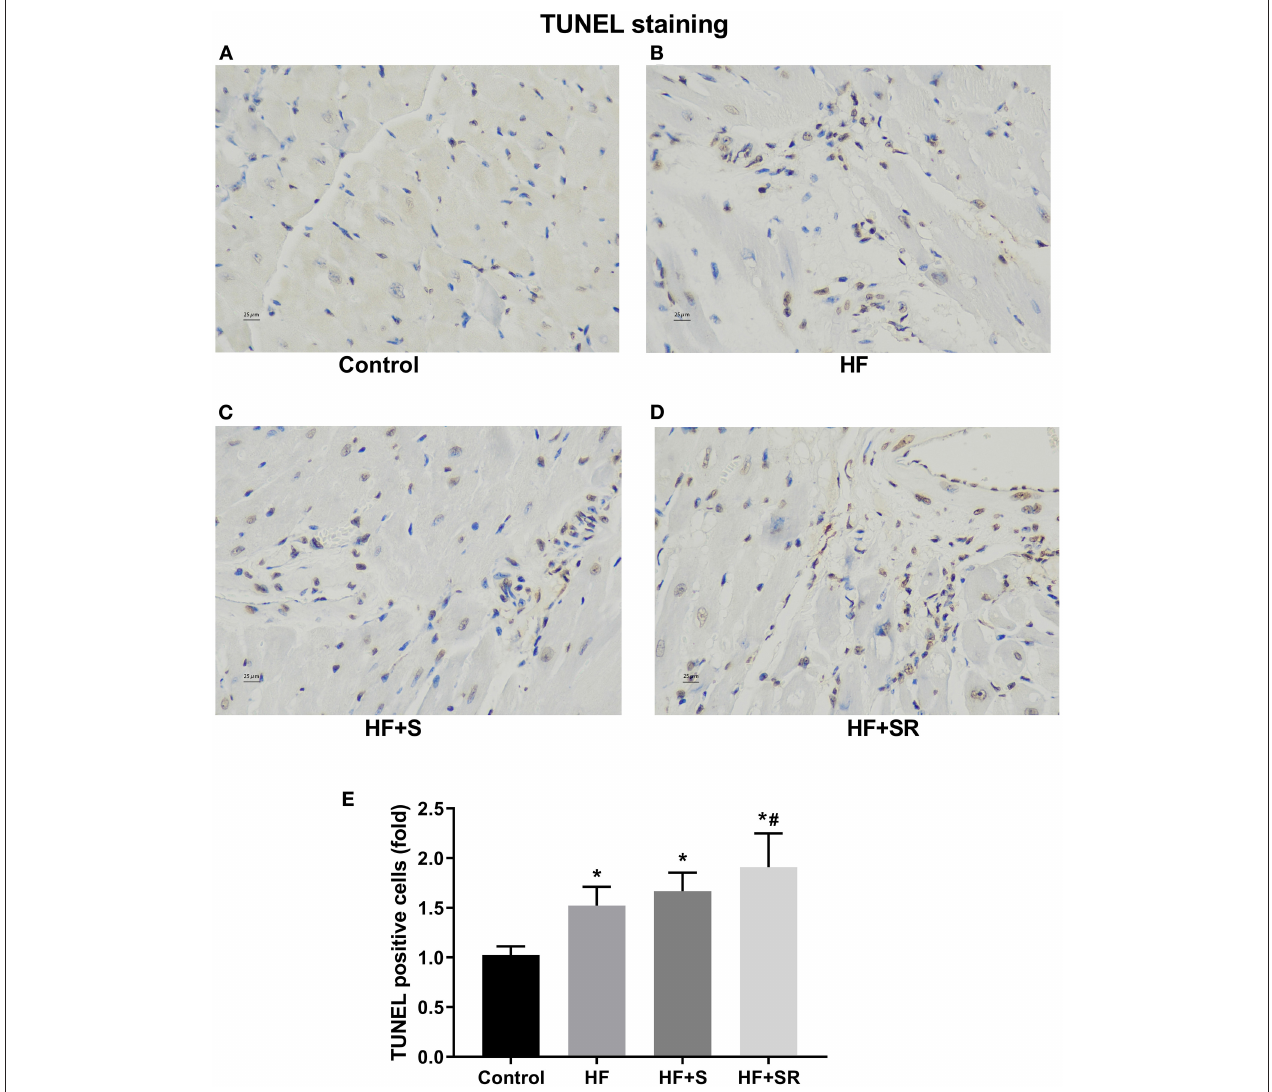
FIGURE 6 | Differences in the number of apoptotic cardiomyocytes among the four groups. Representative photomicrographs of ventricular tissue stained for TUNEL. The controls had very few TUNEL-positive cells (A) . Many TUNEL-positive cells appeared in the HF ( n = 5) and HF + S ( n = 8) mice (B,C) . The percentage of TUNEL-positive cells was significantly increased in the HF + SR mice ( n = 8) (D) . Quantitative analysis of TUNEL-positive cells in the heart sections (E) . * P < 0.05 vs. controls, # P < 0.05 vs. the HF